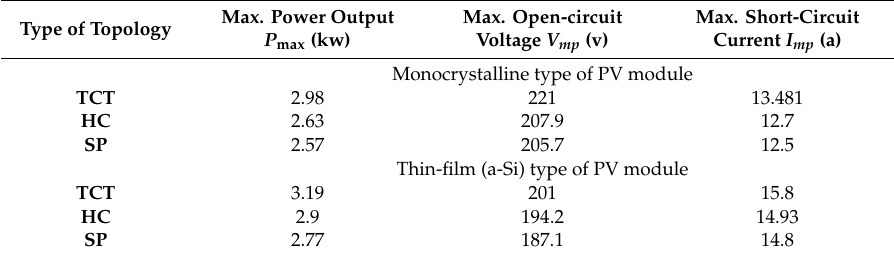
Table 8. Parameters of the PV model for non-uniform shading (F3).